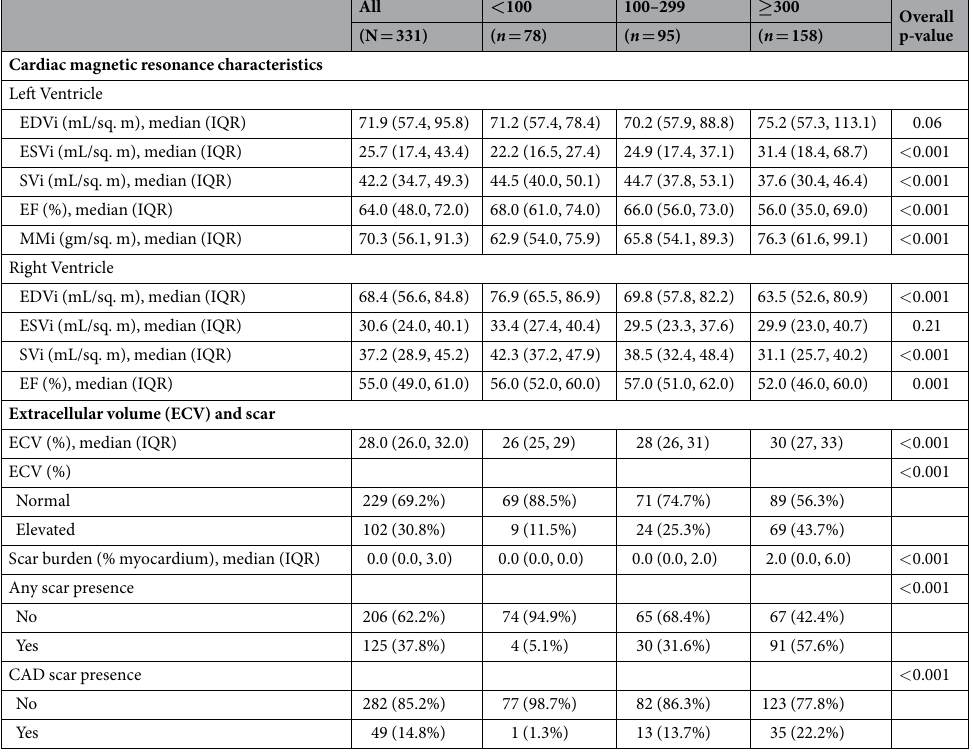
Table 4. Cardiac magnetic resonance characteristics and categorization by N-terminal pro B-type natriuretic peptide (NT-proBNP) levels. IQR, interquartile range; EDVi, end-diastolic volume index; ESVi, end-systolic volume index; MMi, myocardial mass index; SVi, stroke volume index; EF, ejection fraction; ECV, extracellular volume; CAD, coronary artery